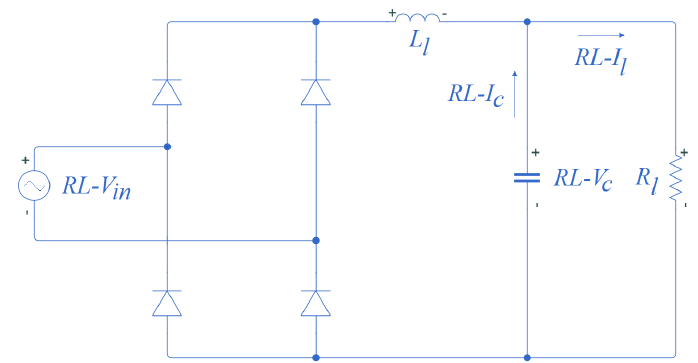
Figure 3. Simulation circuit with load resistor